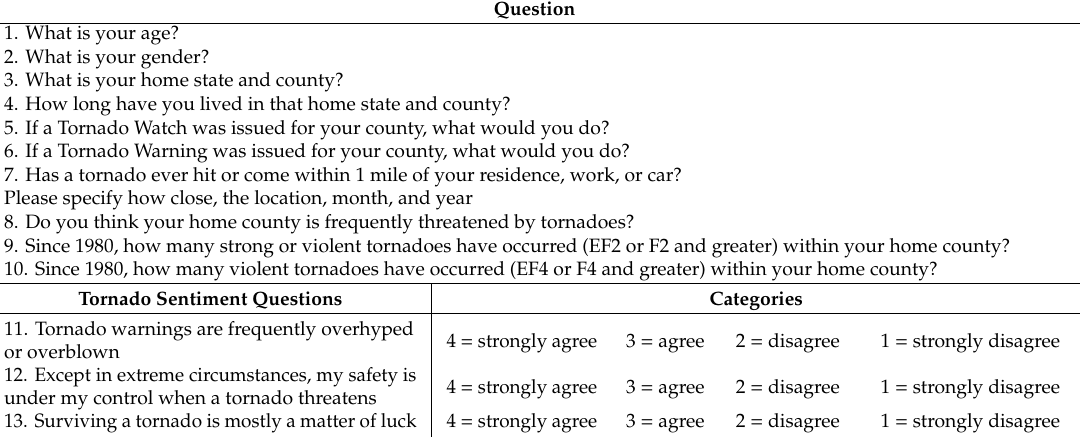
Table 1. List of questions used in this